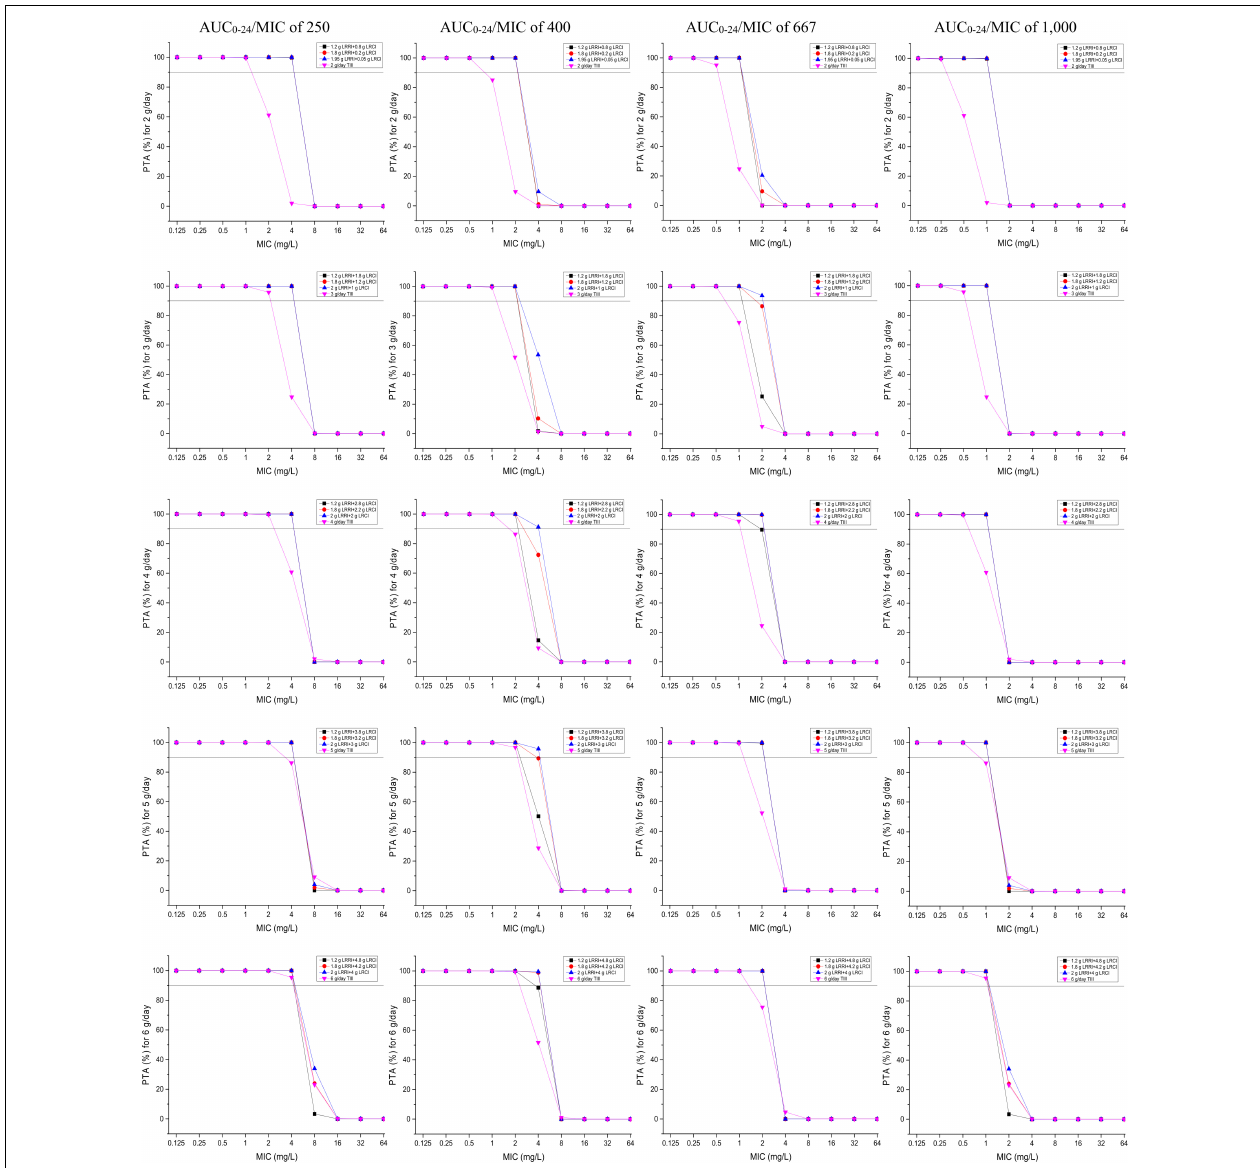
FIGURE 3 | PTAs for various AUC 0 − 24 /MIC targets for MICs of up to 64 mg/L. Considering the profiles of VAN tissue penetration, simulating the target AUC 0 − 24 /MIC of 1,000 is for predicting VAN exposure in lung interstitial fluid and cerebrospinal fluid (i.e., for pneumonia and meningitis), 667 is for predicting VAN exposure in sternal bones (i.e., for sternal osteomyelitis), 400 is for predicting VAN exposure in capsular tissue, pleural fluid, and bloodstream (i.e., for mastitis, pleuritis, and bacteremia), and 250 is for predicting VAN exposure in pericardium (i.e., for bacterial